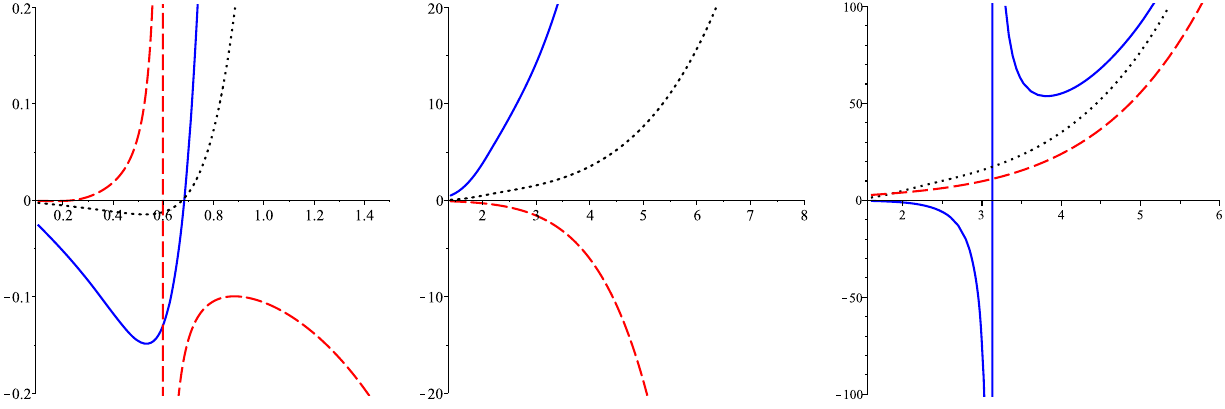
Fig. 9 C P , X versus r + for k = 1, d = 7, q = 1, P = 1 / 8 π , m = 0 . 1, c 0 = c 1 = c 2 = c 3 = c 4 = 1 and α = 0 . 1 (solid line), α = 1 (dotted line) i and α = 10 (dashed line). Different scales: left panel (0 < r + < 0 . 9), middle panel (0 . 8 < r + < 1 . 6) and right panel (1 . 5 < r + <